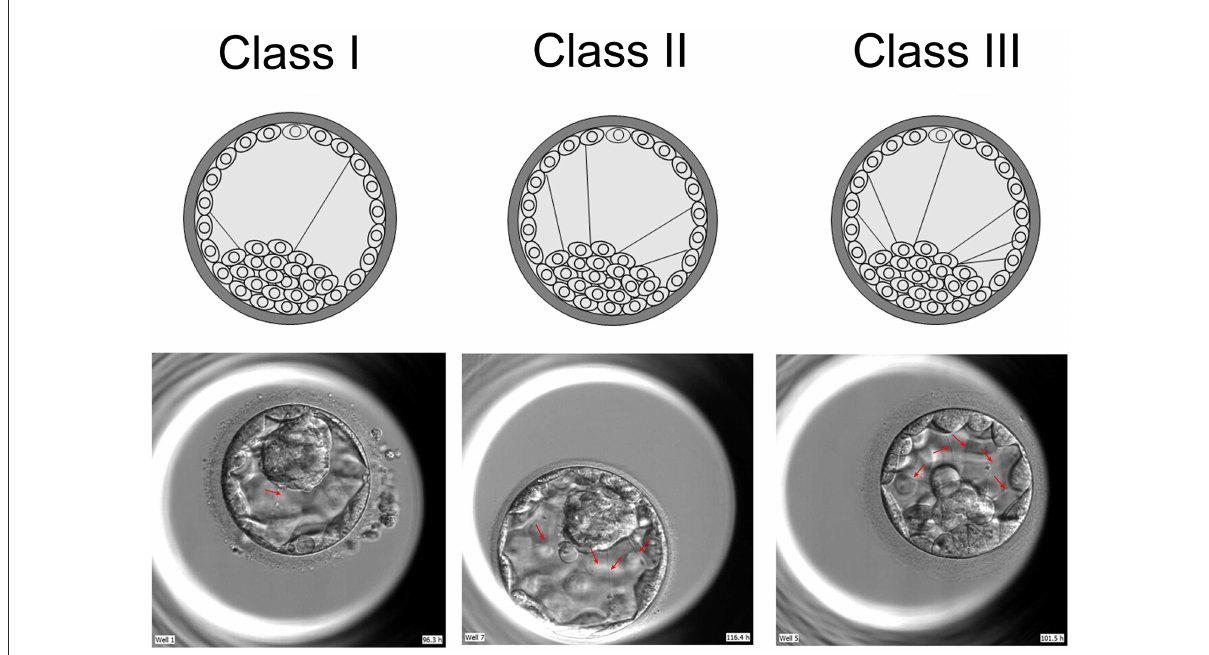
FIGURE2 Classification of cytoplasmic strings between ICM and mTE cells. Threads were classified into three groups, based on their quantity: single and double string (s) (I), three to four strings (II) and more than four strings (III). ICM, inner cell mass; mTE, mural trophectoderm.